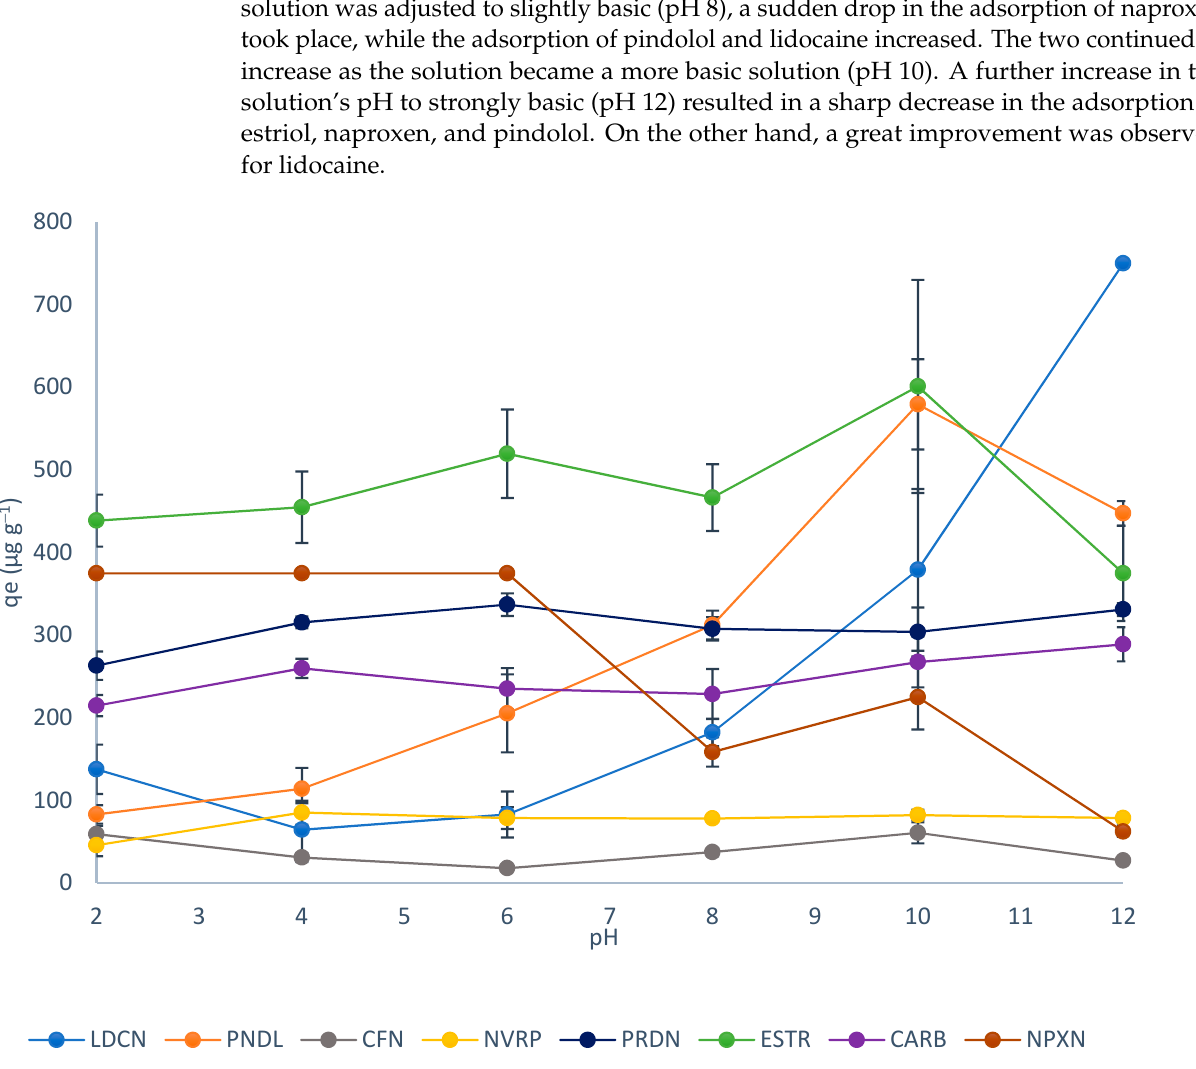
Figure 4. Effect of pH on the adsorption of pharmaceutical drugs.